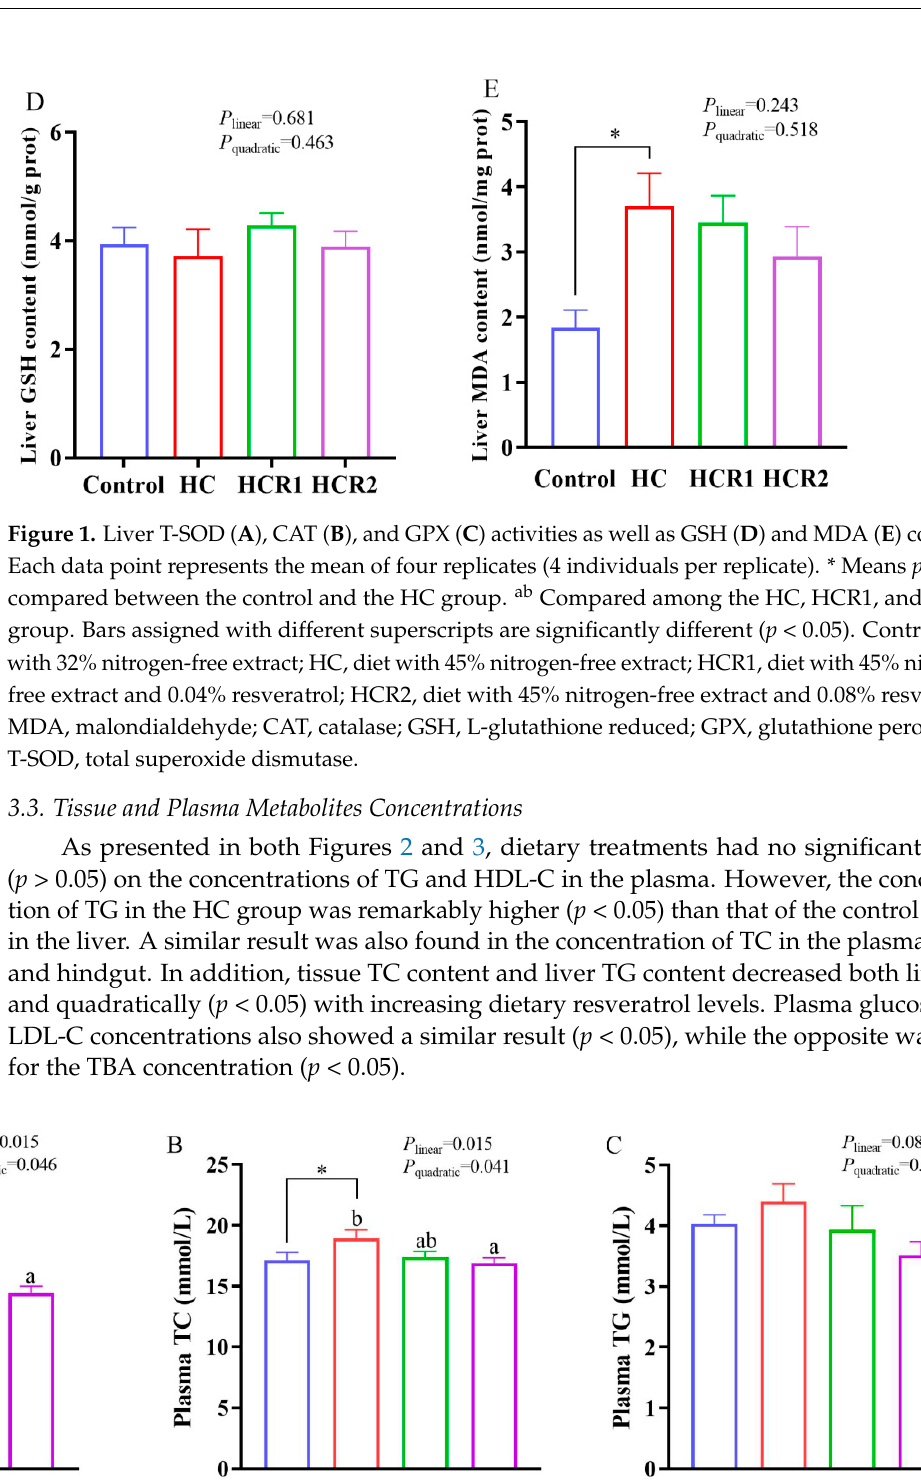
Figure 2. Plasma concentrations of glucose ( A ), TC ( B ), TG ( C ), TBA ( D ), LDL-C ( E ), and HDL-C ( F ). Each data point represents the mean of four replicates (4 individuals per replicate). * Means p < 0.05, compared between the control and the HC group. ab Compared among the HC, HCR1, and HCR2 groups. Bars assigned with different superscripts are significantly different ( p < 0.05). Con- trol, diet with 32% nitrogen-free extract; HC, diet with 45% nitrogen-free extract; HCR1, diet with 45% nitrogen-free extract and 0.04% resveratrol; HCR2, diet with 45% nitrogen-free extract and 0.08% resveratrol. TC, total cholesterol; TG, total triglycerides; TBA, total bile acid; HDL-C, high-density lipoproteins cholesterol; LDL-C, low-density lipoproteins cholesterol.